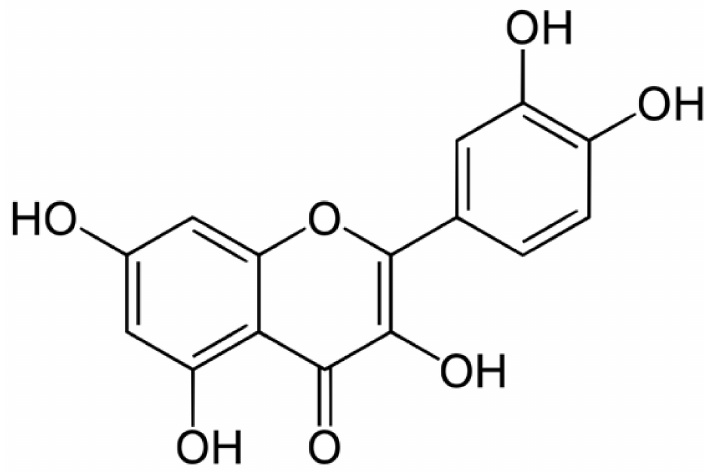
Figure 1. Molecular structure of